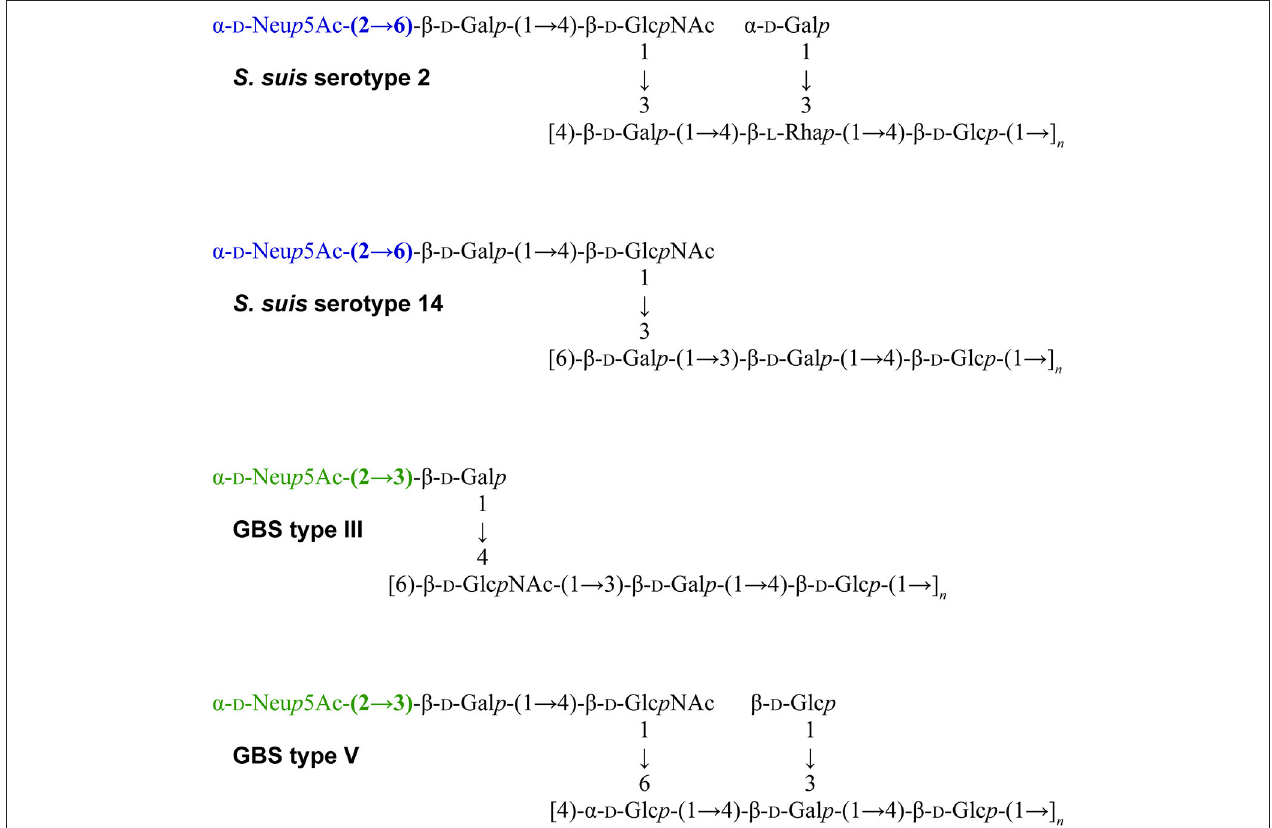
FIGURE 1 | Reported structures for the capsular polysaccharide repeating units of S. suis serotypes 2 (Van Calsteren et al., 2010) and 14 (Van Calsteren et al., 2013) and of Group B Streptococcus (GBS) types III ( Wessels et al., 1987; Wessels and Kasper, 1990) and V (Wessels et al., 1991).